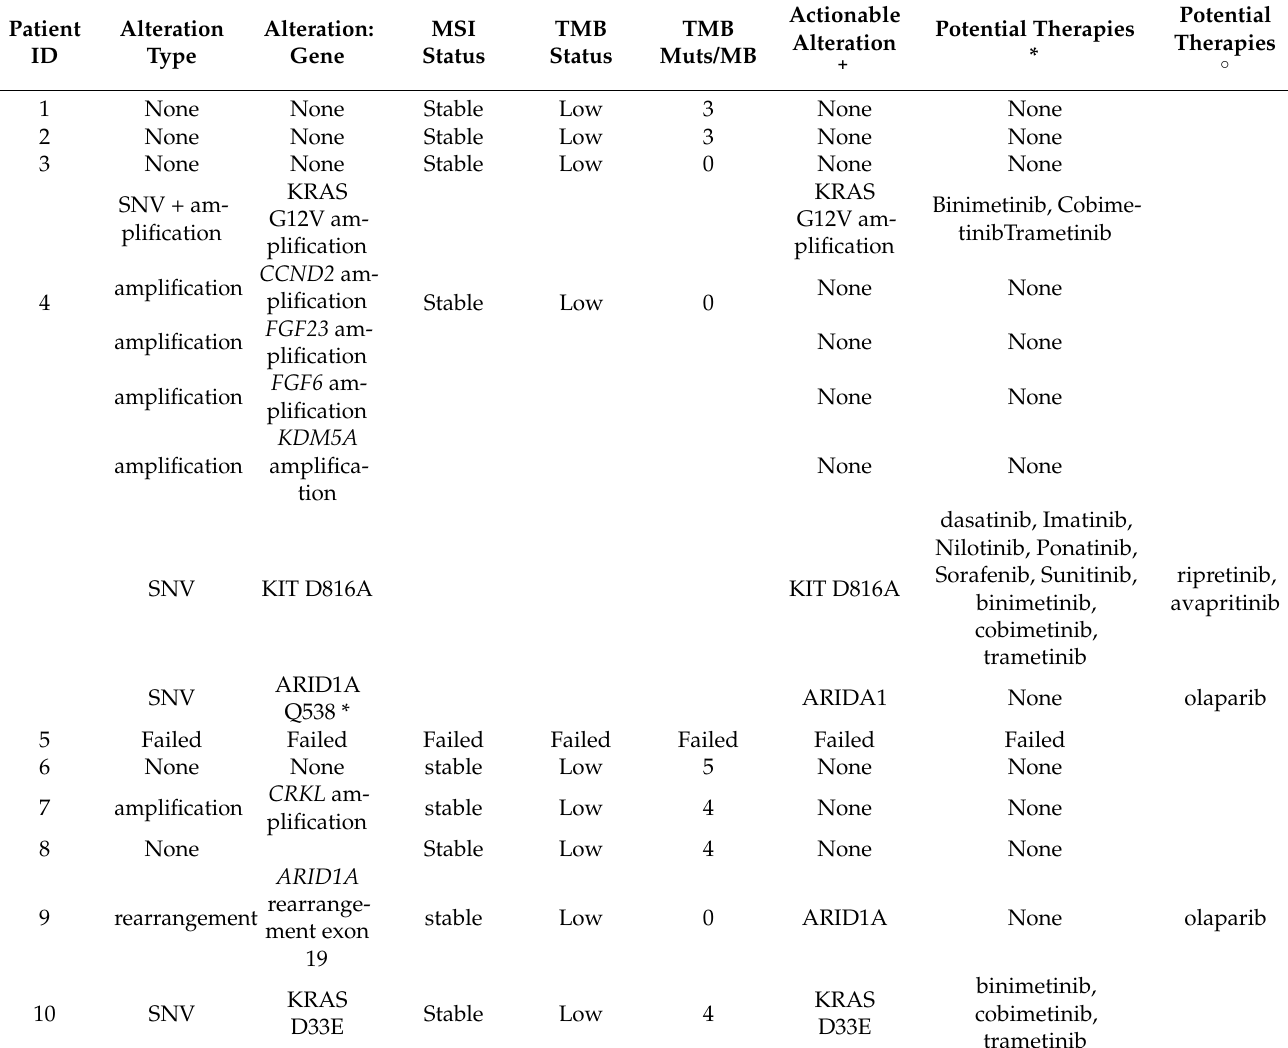
Table 4. Molecular